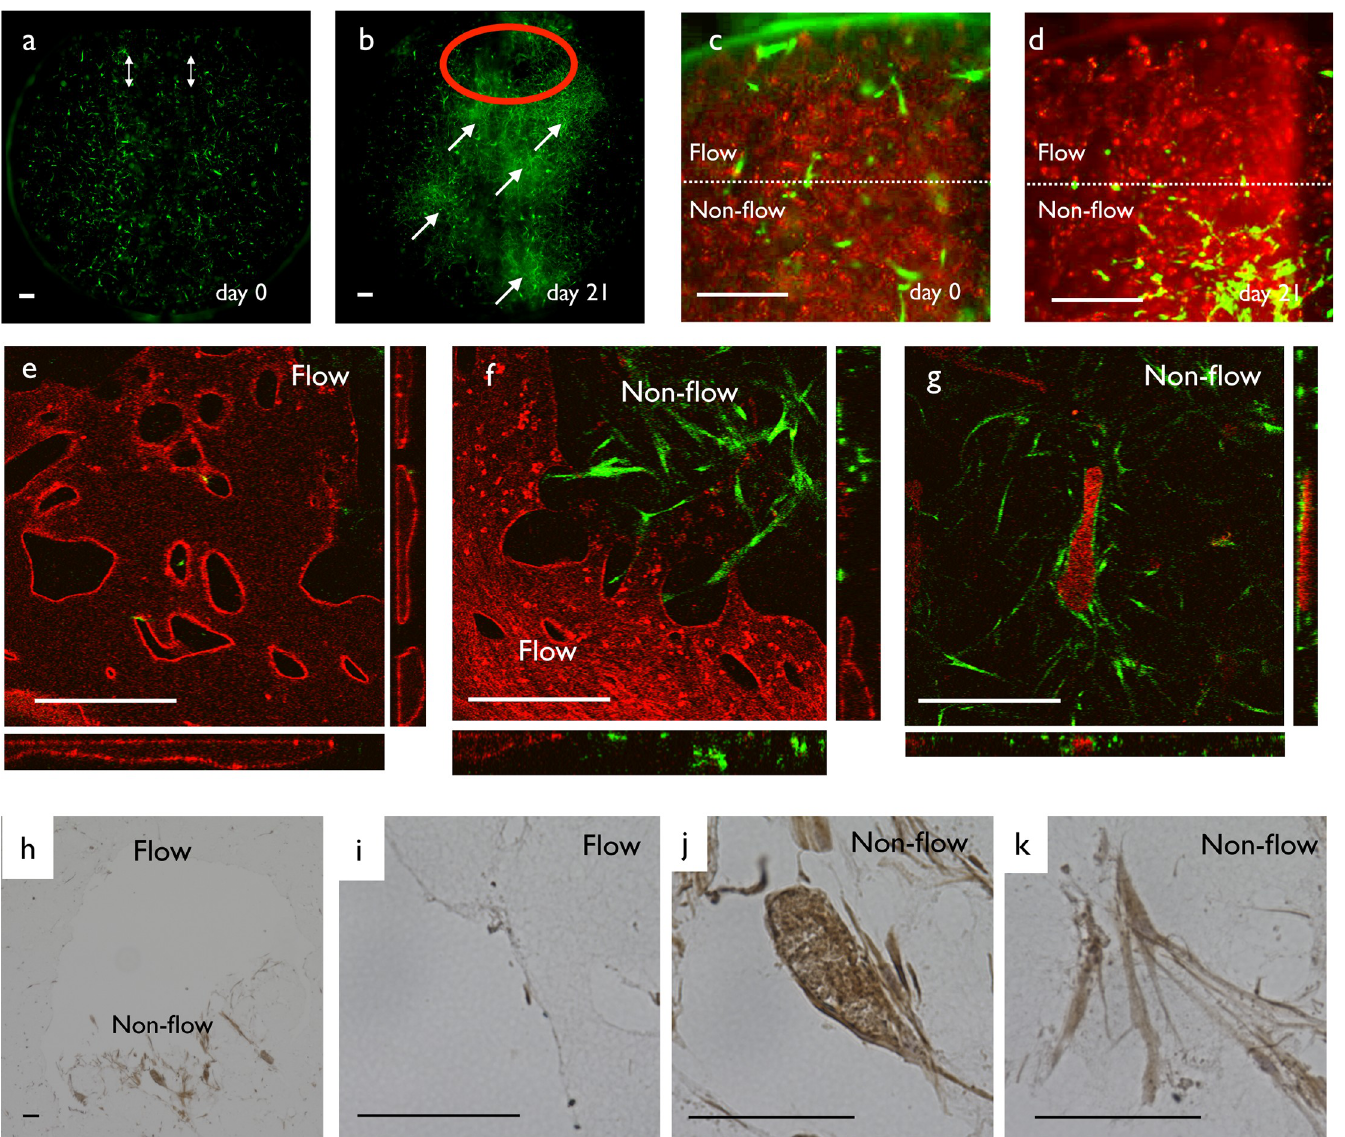
Fig 5. Dynamics of pericytes in the HUVEC-pericyte coculture system. (a) Low magnification view of the distribution of pericytes at day 0 (green). White arrows indicate the inlet and outlet. (b) Distribution of pericytes after 21 days of perfusion culture. We observed a high density region of pericytes (arrows) in the non-flow region and a low density region (red circle) in the flow region. (c) High magnification view of pericyte distribution at the flow region (day 0). (d) High magnification view of the pericyte distribution at the flow region (day 21). Pericyte cell density was decreased in flow region and increased in non-flow region. (e) 3D structure of the flow region at day 30. Endothelial cells (red) formed vasculature with a perfusable lumen. Pericytes were virtually absent. (f) Boundary between flow and non-flow regions. Pericytes resided in the non-flow region. (g) 3D structure of the non-flow region. Vasculature was degraded and flat cysts of endothelial cells with cell debris inside remained. Pericytes appeared to surround the degraded structure. (h) Low magnification view of PDGFBB immunohistochemistry. A positive signal was observed in the non-flow region. (i) High magnification view of the flow region. No positive signal was observed. (j) High magnification view of the non-flow region. The cell cyst and surrounding pericytes had a high staining intensity. (k) High magnification view of pericytes in the non-flow region. A positive signal was observed in the cytoplasm. Scale bars: 500 μ m (a–g); 100 μ m (h–k).